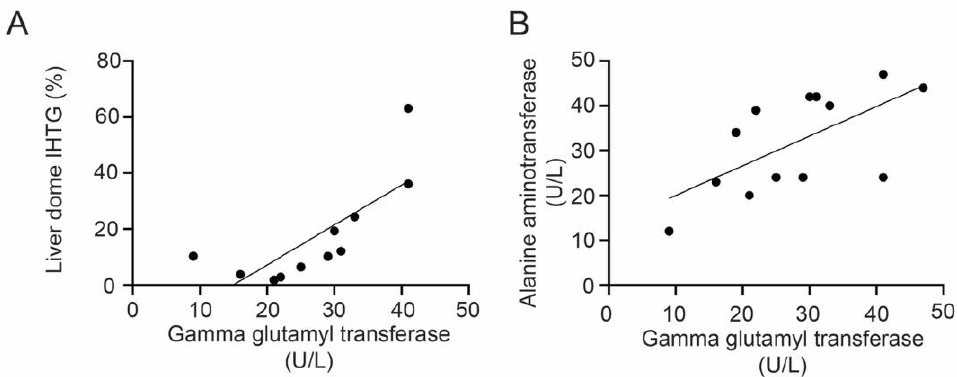
Figure 2. There was a significant correlation between ( A ) the liver dome intrahepatic triacylglyc- erol (IHTG) content and the serum γ -glutamyl transferase ( r = 0.58, p = 0.0063) and ( B ) serum alanine aminotransferase and serum γ -glutamyl transferase ( r = 0.41, p = 0.018) in the motor neuron disease group.